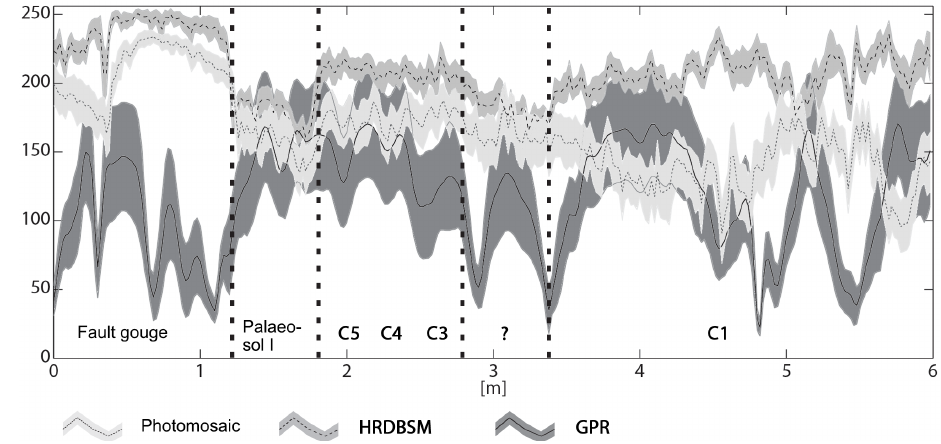
Figure 7. Varying reflectance of electromagnetic waves along the trench wall. Transitions between individual layers are depicted by drastic changing shapes of reflectance spectra. The error range is given by the standard deviation of each